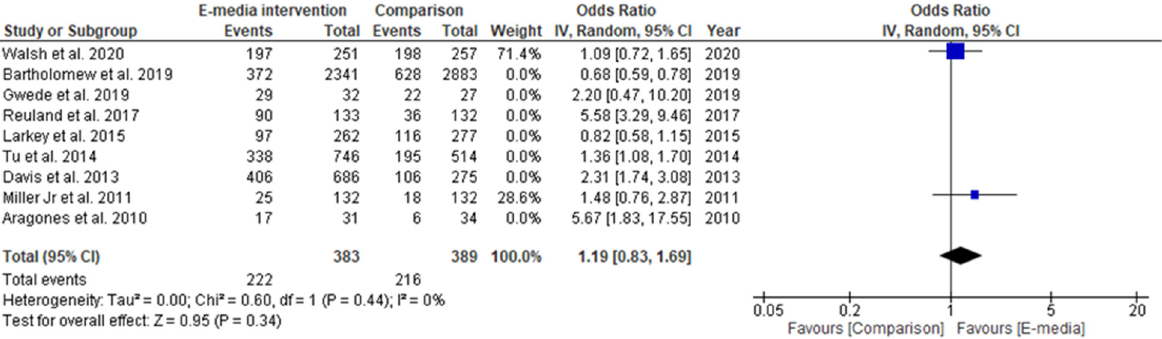
Figure 6. Random-effects forest plot for studies using interactive programs as intervention ( n = 2). Box size represents study weighting. Diamond represents overall effect size and 95% CI.